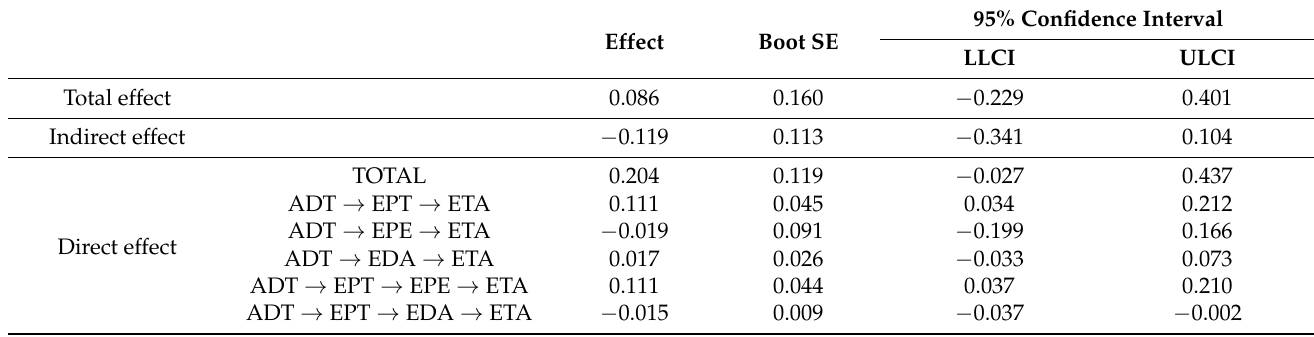
Table 5. Mediating effect